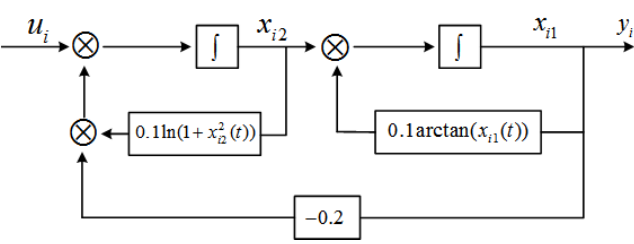
Figure 1. Block diagram of system